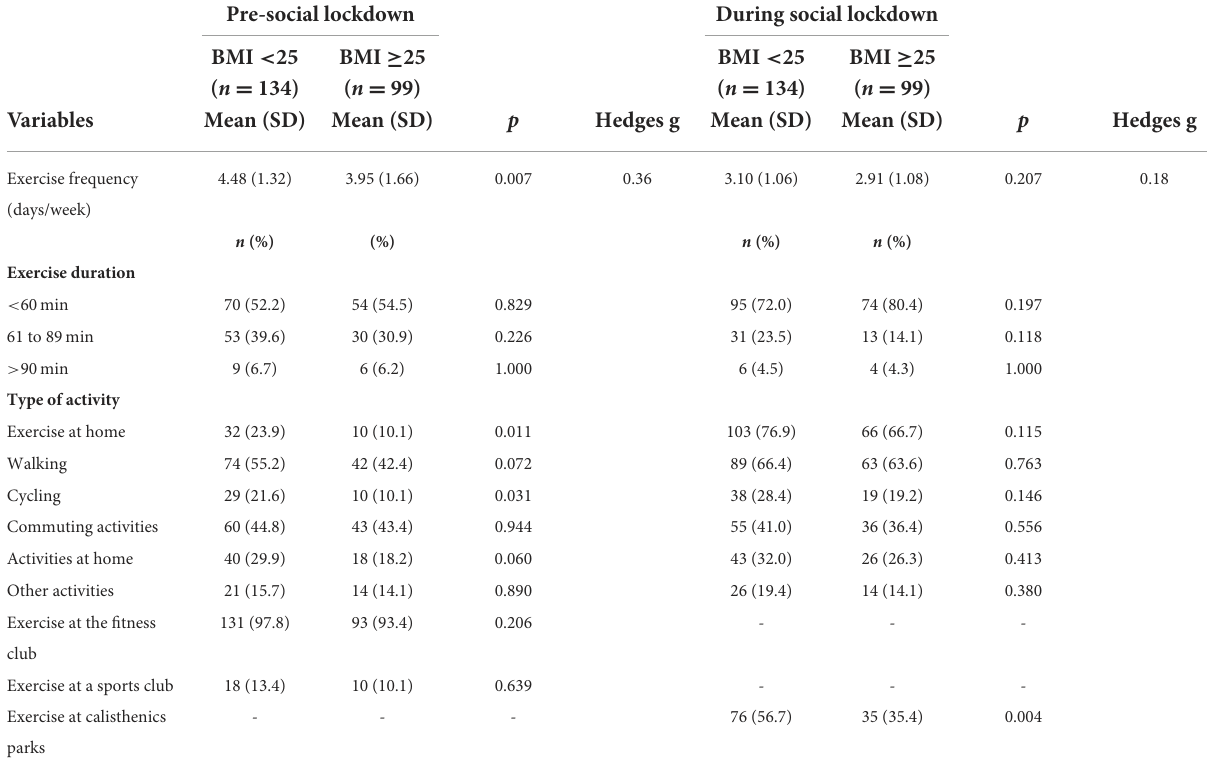
TABLE 4 Comparison of exercise habits pre-and during lockdown between BMI